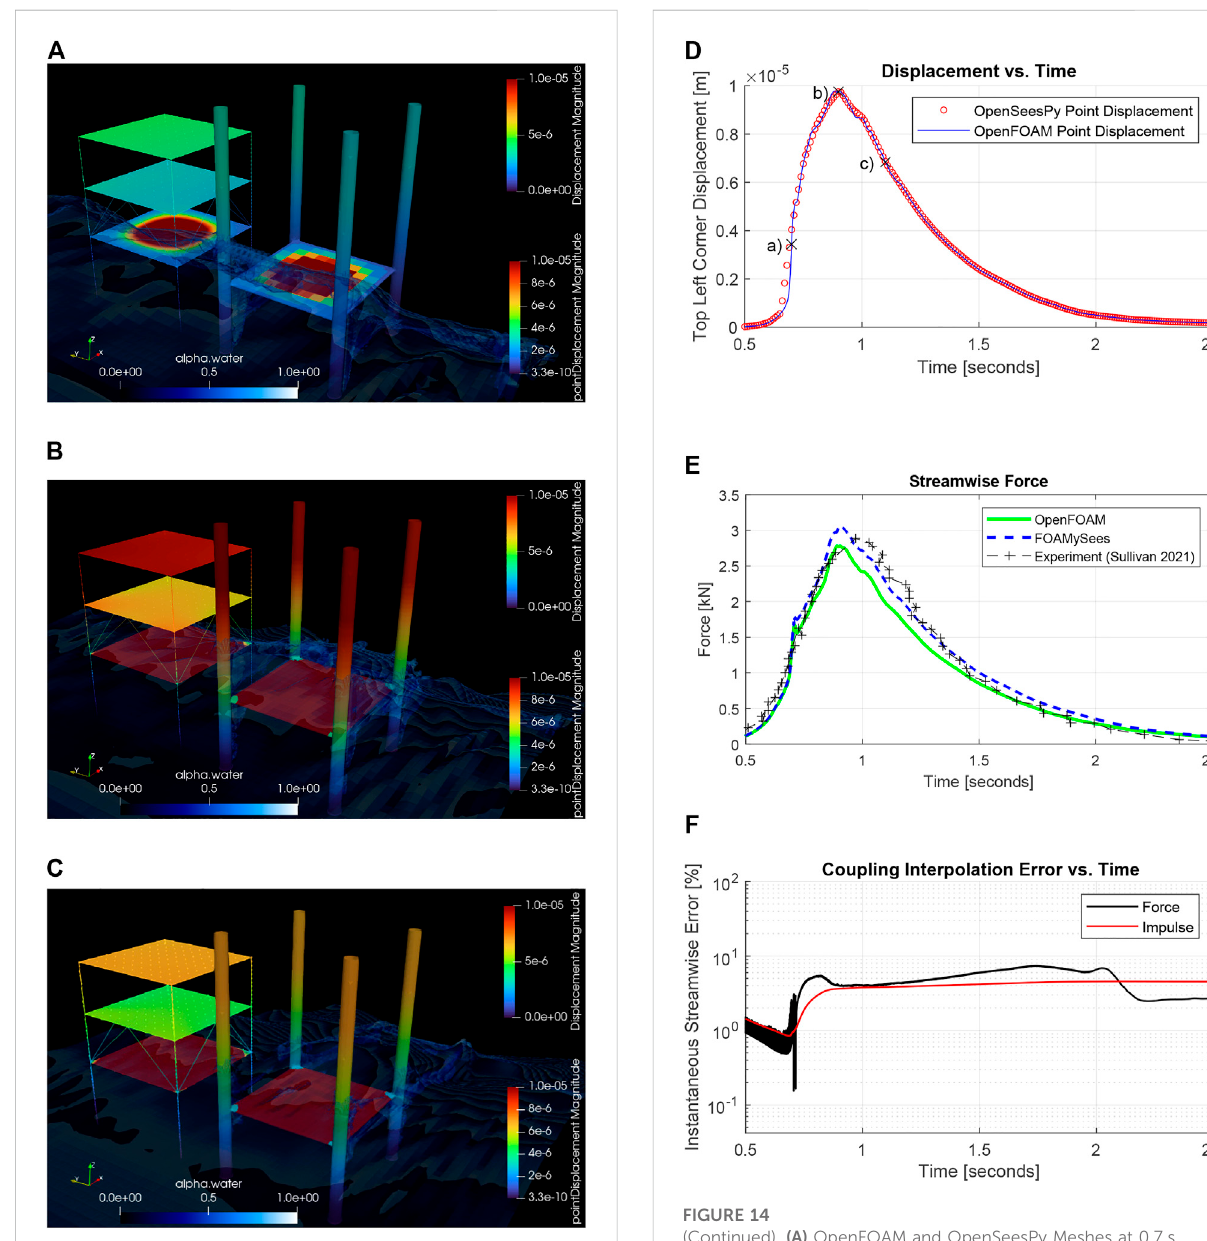
(Continued). (A) OpenFOAM and OpenSeesPy Meshes at 0.7 s with fl uid free surface, (B) OpenFOAM and OpenSeesPy Meshes at 0.9 s with fl uid free surface, (C) OpenFOAM and OpenSeesPy Meshes at 1.1 s with fl uid free surface, (D) OpenFOAM and OpenSeesPy Displacement Over Time for Point of Maximum Lateral Displacement (Top of Left Front Column), (E) Streamwise Force Comparison Between Experiment, OpenFOAM CFD, and FOAMySees FSI, (F) Percent Error in Streamwise Force and Impulse Transfer Between OpenFOAM and FOAMySees